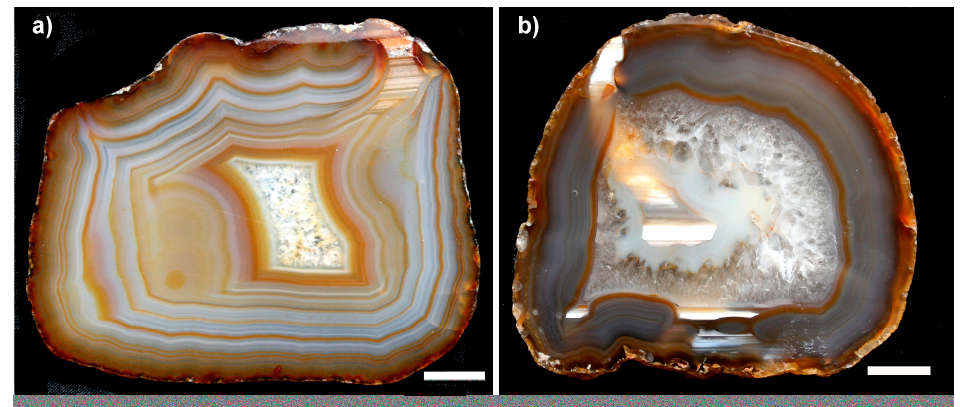
Figure 8. ( a , b ) Two Brazilian agates showing similar horizontal banding in the infiltration canals. Scale bar = 1 cm.